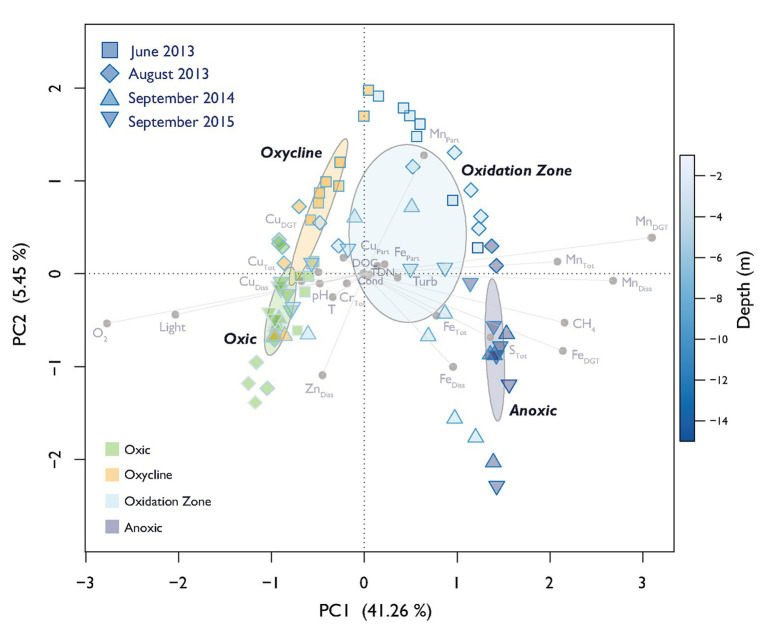
Principal component analysis (PCA) of physico-chemical variables. Dispersion ellipses depict the standard error of weighted average scores of depth zone groupings (confidence limits = 0.95). Symbols show scores of individual samples. The sampling date and assigned depth zones are colored accordingly. The color of the symbol outline illustrates the depth of the respective sample according to the depicted color gradient. The color of the symbol filling encodes the affiliation to the specific depth zone. Environmental variable loadings are depicted in light gray. Explained variance of PC1 and PC2 are given in parenthesis.